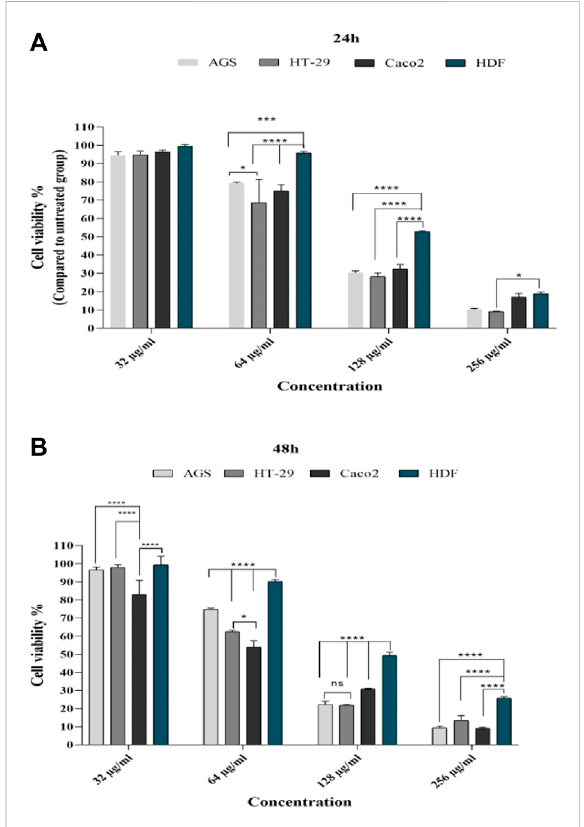
FIGURE 2 Comparison of cell viability in cell lines with different concentrations of T. canis ES TPP after 24 (A) and 48 h (B) of exposure; after 24 h, at a concentration of 32 μ g/ml, cancer cells had a decrease in cv compared to normal cells (not statistically signi fi cant); a signi fi cant difference was observed from theconcentrationof64 μ g/ml;after24 h,thehighesteffectwasin the concentration of 128 μ g/ml and the lowest effect was in the concentration of 256, while after 48 h, the effect of 256 μ g/ml along with other concentrations was very signi fi cant (ns, not signi fi cant; * p < 0.05; ** p < 0.01; *** p < 0.001; **** p <